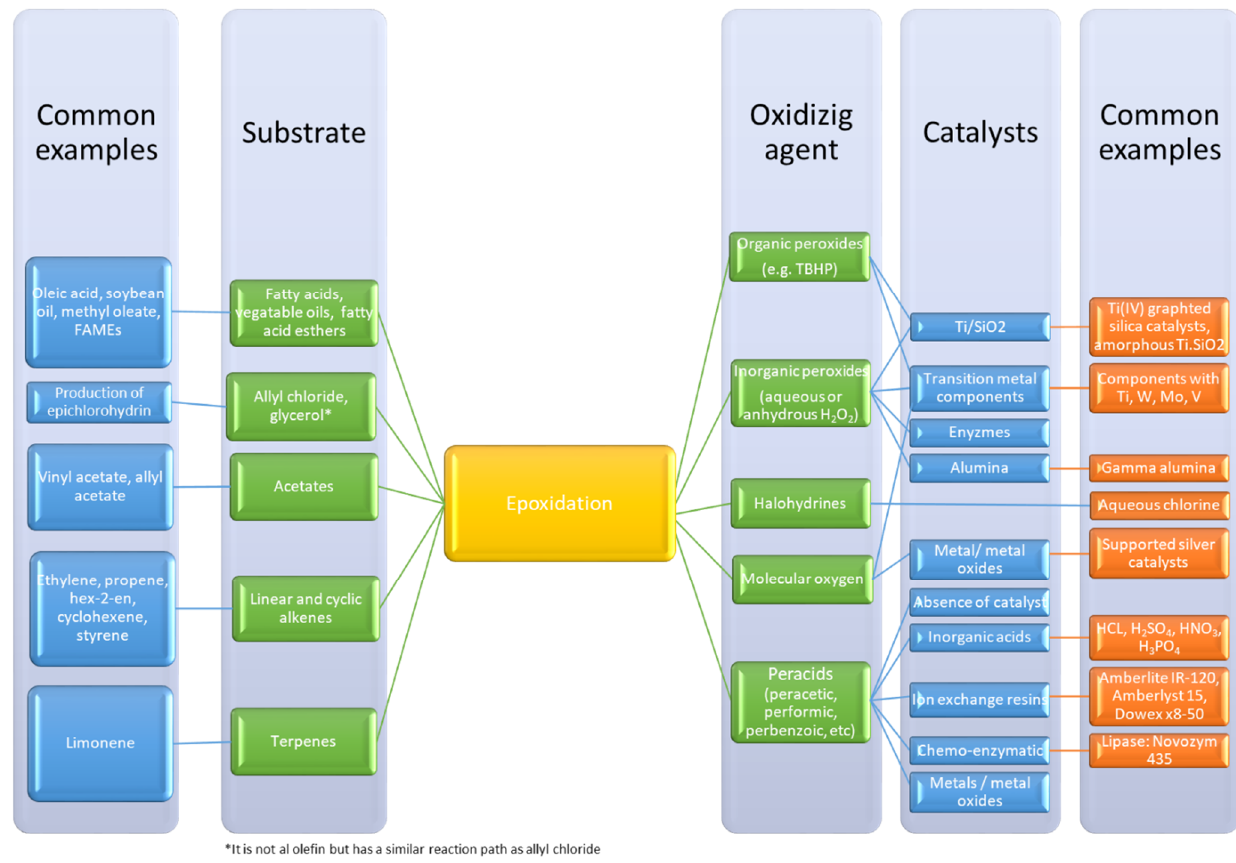
Figure 1. Overview of common epoxidation methods and routes.